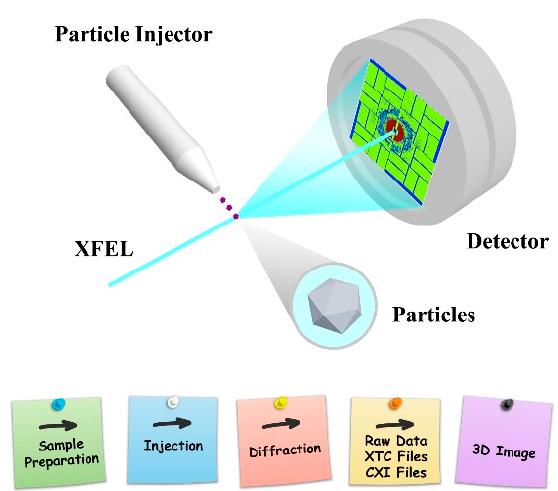
Figure 4. Schematic layout of a single-particle imaging measurement using femtosecond XFEL pulses. Nanoparticles and viruses are injected to the XFEL focus by a particle injector or a fixed target system